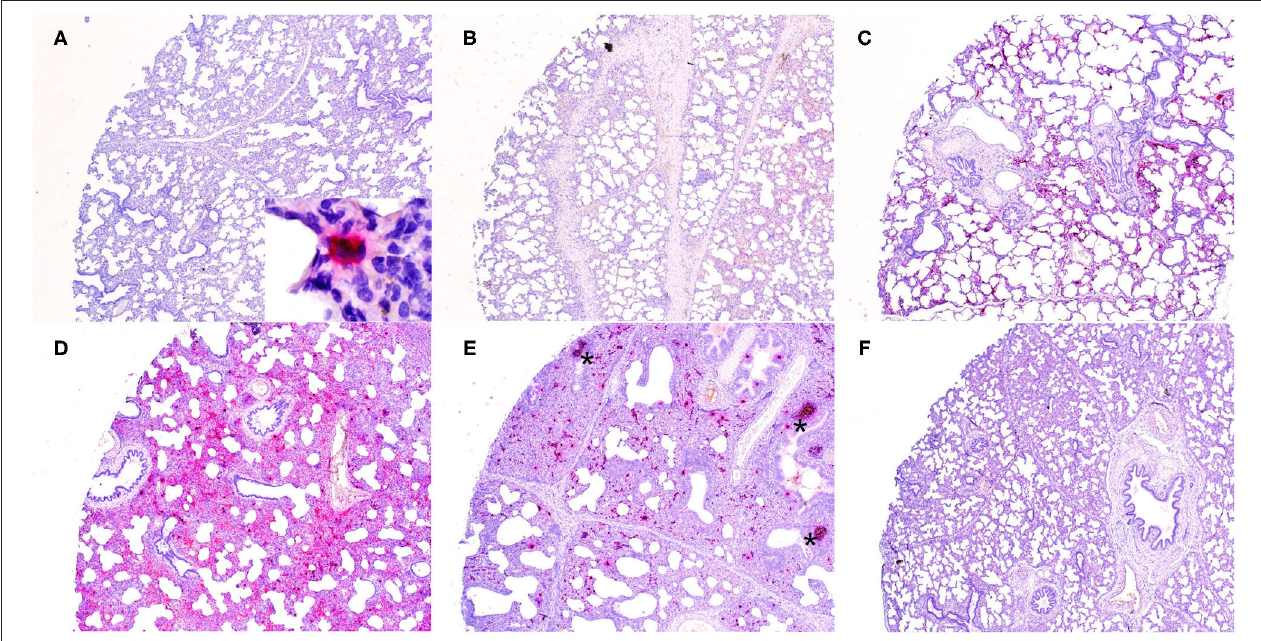
FIGURE 1 | Detection of porcine parvovirus 2 (PPV2) nucleic acid in the lungs obtained from porcine respiratory disease complex-affected pigs by in situ hybridization (ISH, × 40). The ISH signals of PPV2 ranged from a focal single individual cell (A) to multifocal (B,C) to diffuse (D,E) . No signal was detected in a tissue core obtained from a PPV2 qPCR-negative case (F) . Note that the signals of PPV2 were mainly detected in the pulmonary interstitium and activated lymphoid follicles ( asterisk ) in peribronchial lymphoid tissues (E)